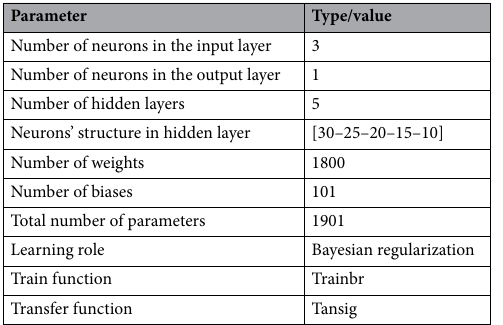
Table 1. Configuration details of the MLP network utilized for modeling of H 2 S